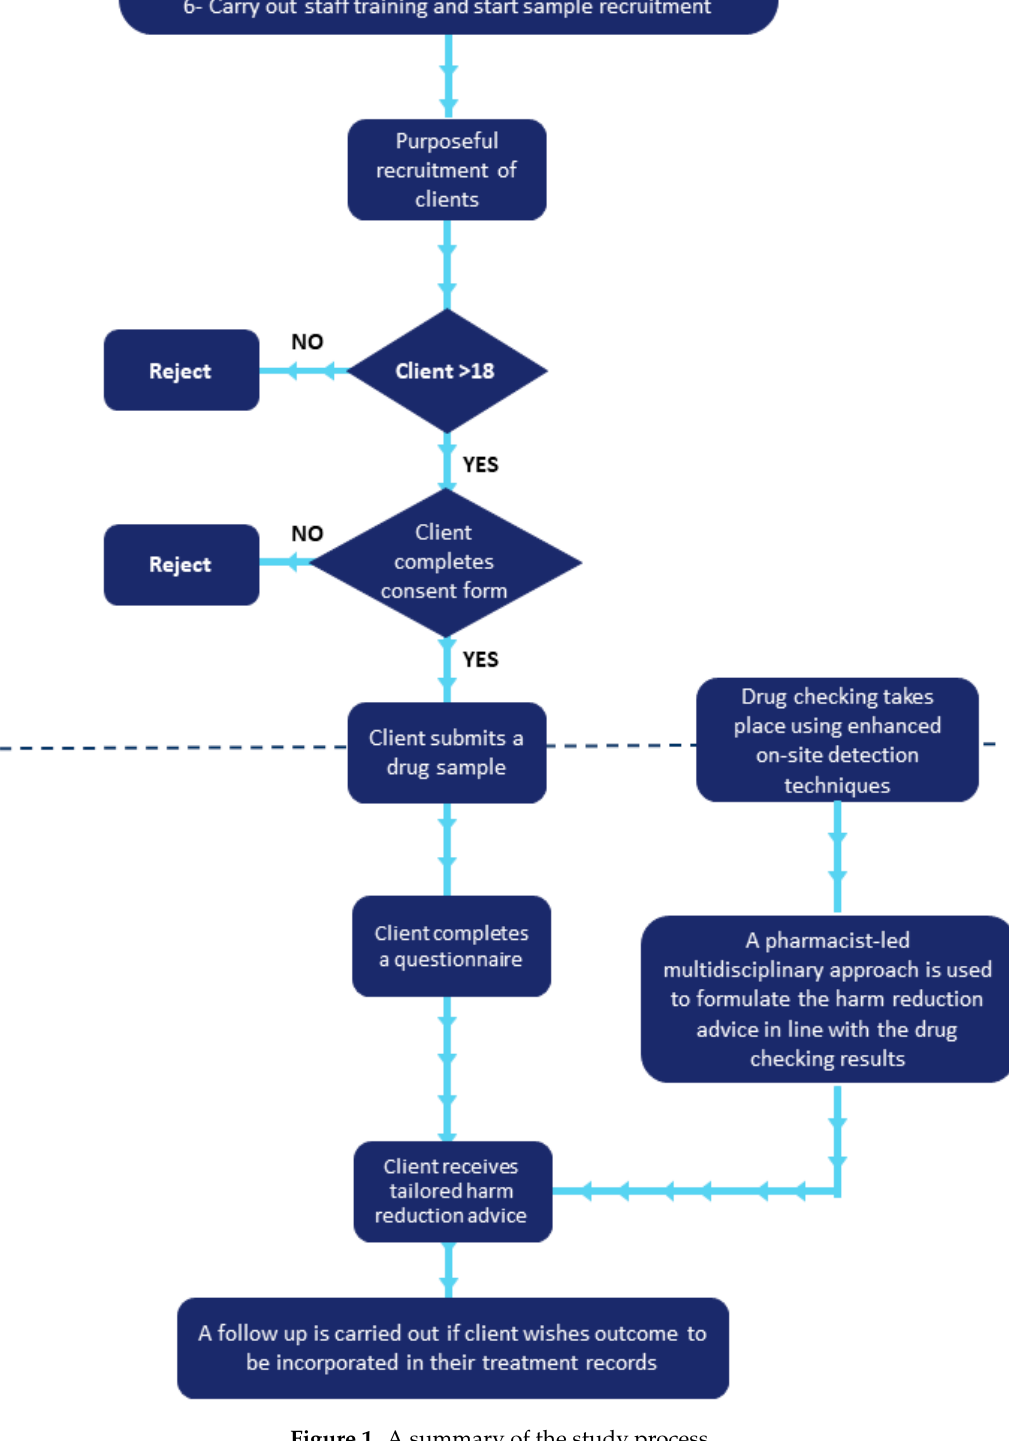
Figure 1. A summary of the study process.